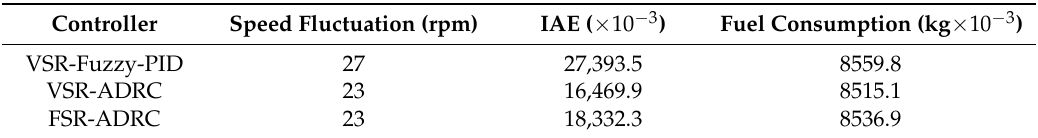
Figure 9. The control performance comparison of different controllers during the load disturbance conditions under standard engine model: ( a ) The total resistance torque; ( b ) the speed responses; ( c ) the control input. Table 2. The performance comparison of different criterions for the controllers with wave load disturbances under standard engine model.